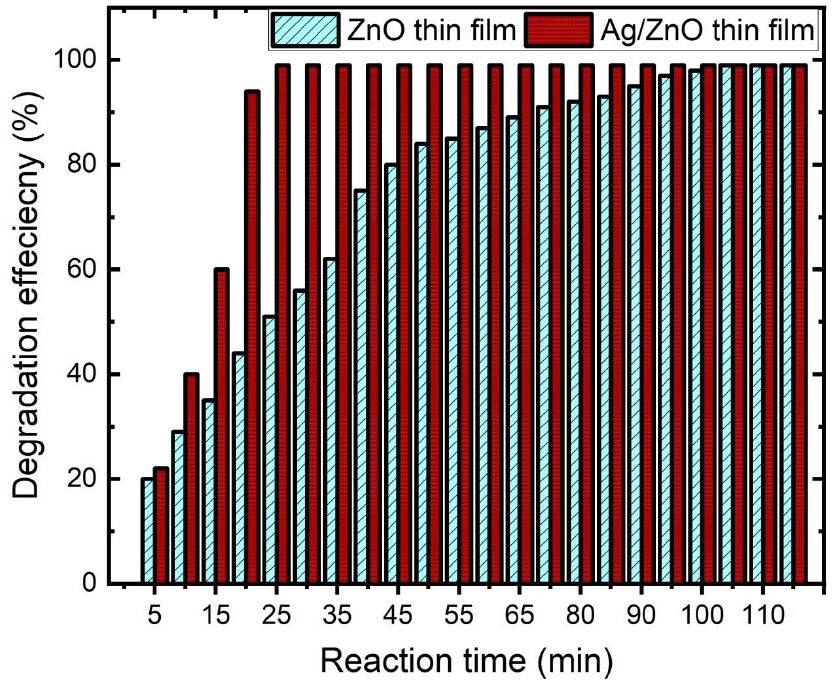
Figure 6. Degradation efficiency of ZnO thin film before and after being embedded with Ag thin films against 4-NP .